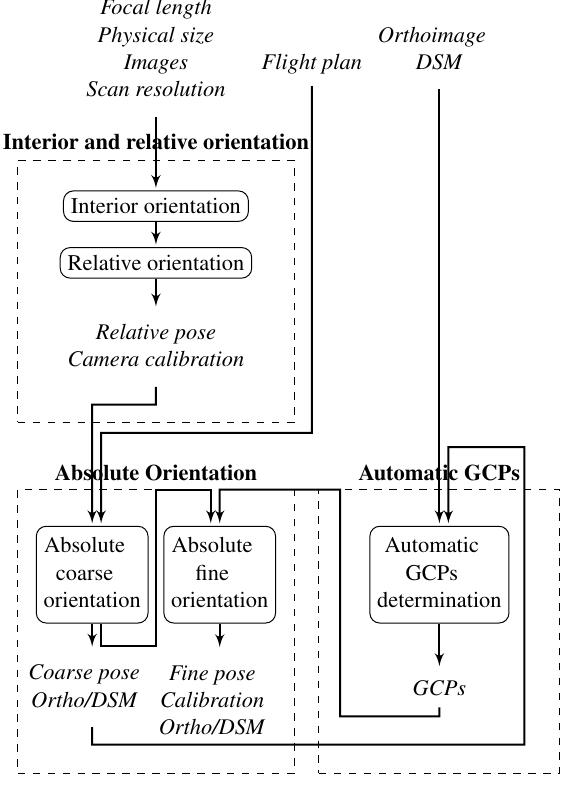
Figure 3. Proposed method. See text for more